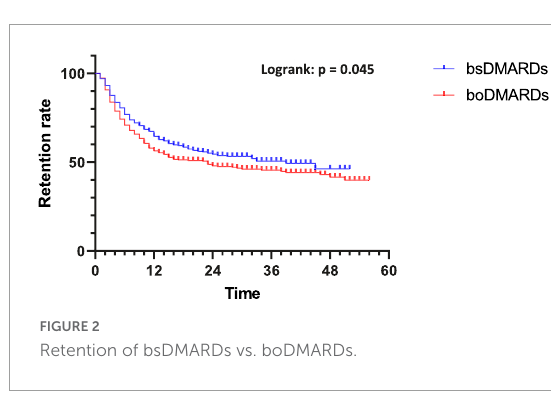
FIGURE2 Retention of bsDMARDs vs. boDMARDs.